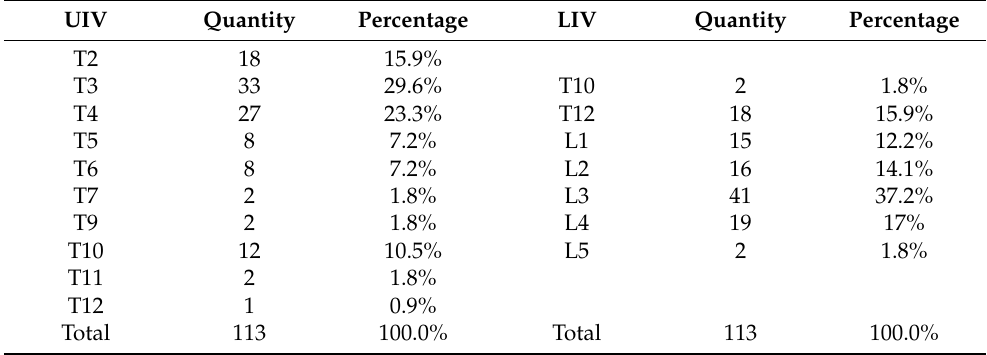
Table 3. Distribution of the upper instrumented levels (UIV) and lower instrumented levels (LIV) of the study